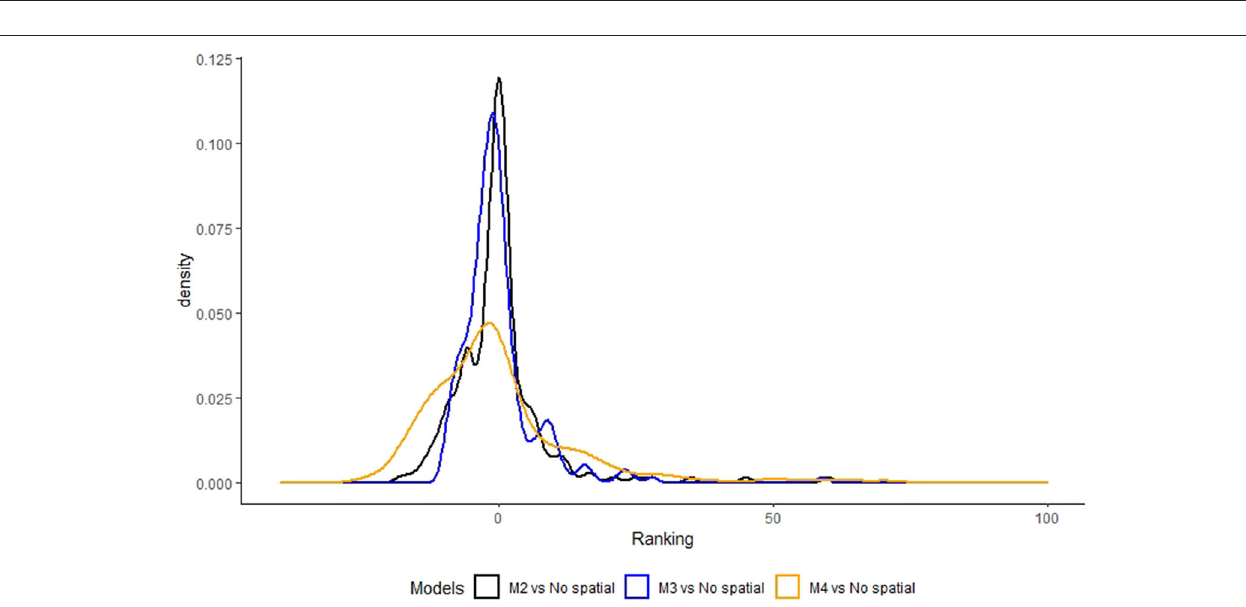
FIGURE 10 | Model 4 vs. non spatial: Farm technical efficiency distribution for irrigated farms at different cut-off distances.